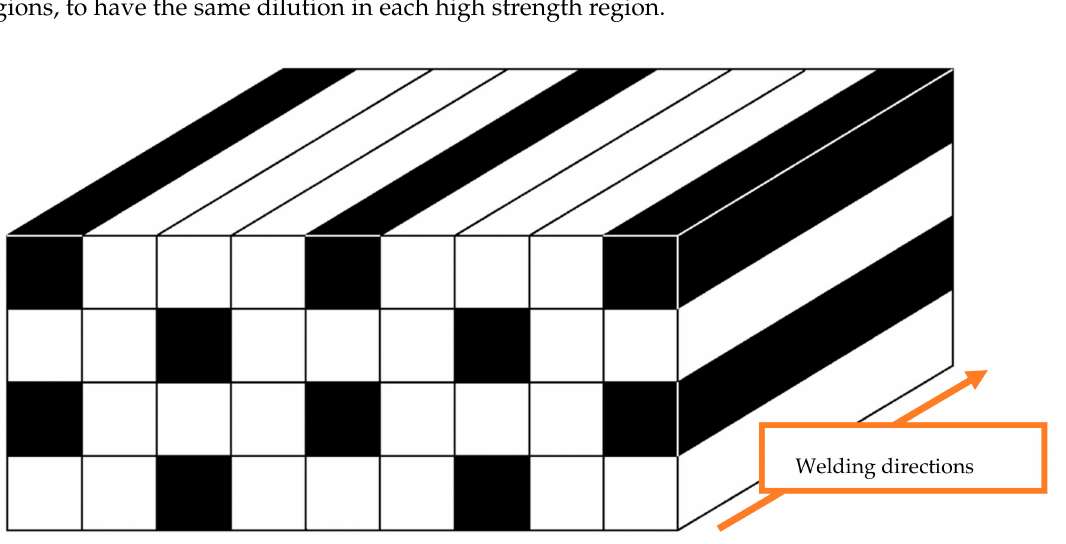
Figure 1. Distribution of layers (white: Soft matrix, black: High-strength